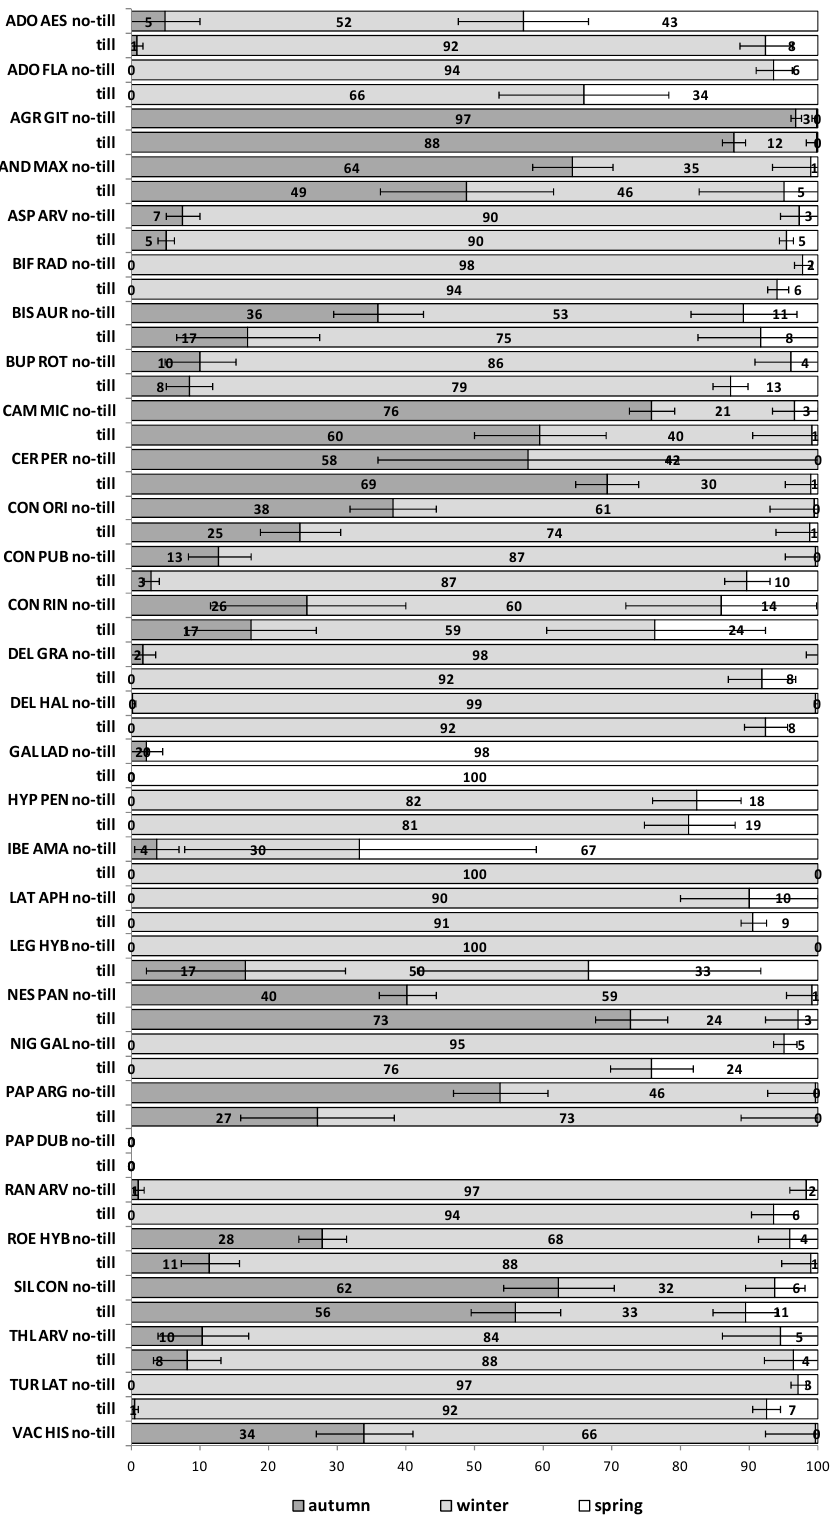
Figure A4. Relative Emergence patterns of 30 RAPs in autumn, winter, and spring during the first season (2013/2014) for seeds sown in 2013 (S2) in an arable field trial in Spain. Bars represent standard error. Two burial conditions are shown: 1 cm burial depth without soil disturbance (no-till) and 1–10 cm depth with annual autumnal soil disturbance (till).